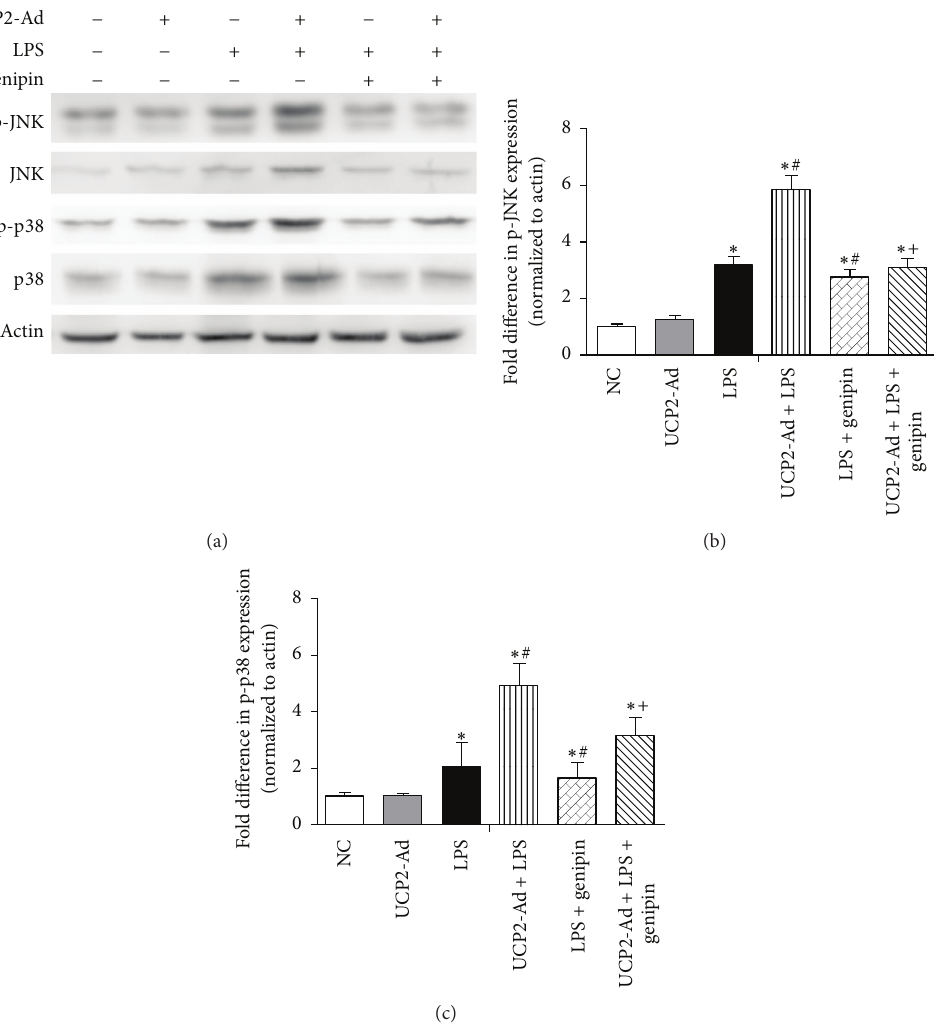
Figure 6: Genipin attenuated LPS-induced inflammatory lung injury via JNK and p38 MAPK pathway. (a) Western blot analysis shows the role of genipin in the activation of JNK and p38 in lung tissue after ALI. (b) Quantification of p-JNK immunoreactivity using Western blot analysis. (c) Quantification of p-p38 immunoreactivity using Western blot analysis. ( ∗ 𝑃 < 0.05 versus NC group, # 𝑃 < 0.05 versus LPS group, and + 𝑃 < 0.05 versus UCP2-Ad + LPS group). Values are presented as means ± SEM ( 𝑛 = 3